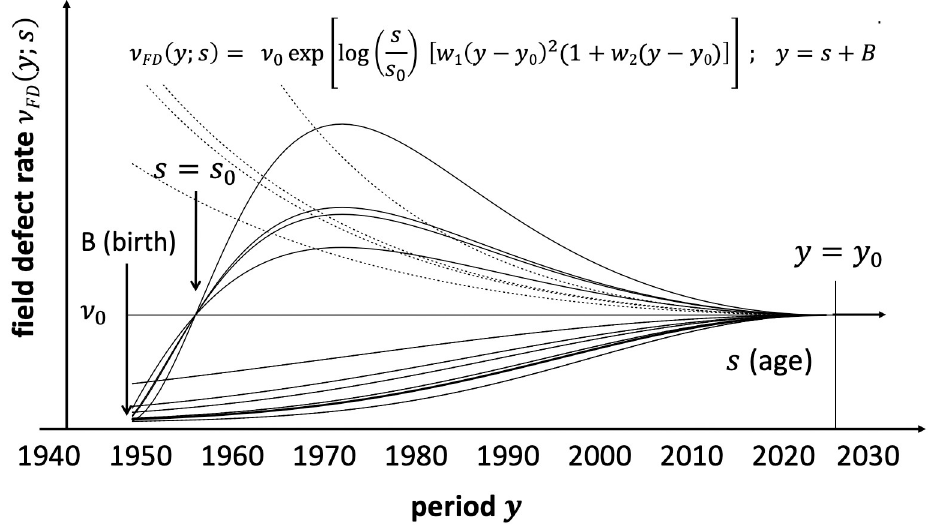
Fig 2. Functional regularization of period (year) trends on the field-defect rate ν FD . The parameters s 0 , y 0 , w 1 , w 2 and ν 0 are estimated from the data. Note, ν FD approaches the background rate ν 0 smoothly at the reference point y 0 and is assumed to remain constant for y > y 0 . Here s refers to age, B to birth year, y to period. For illustration, we also show some randomly generated ν FD trajectories with the attenuating term log( s / s 0 ) included (solid lines) and with this term omitted (dotted